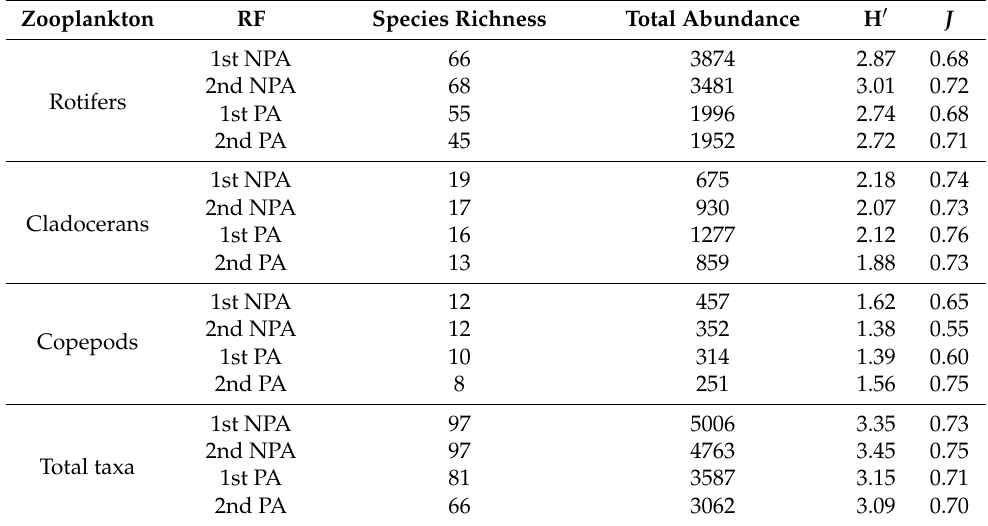
Table 2. Species richness, abundance (individuals), and diversity indices in the zooplankton commu- nity in RF-NPA and RF-PA on two